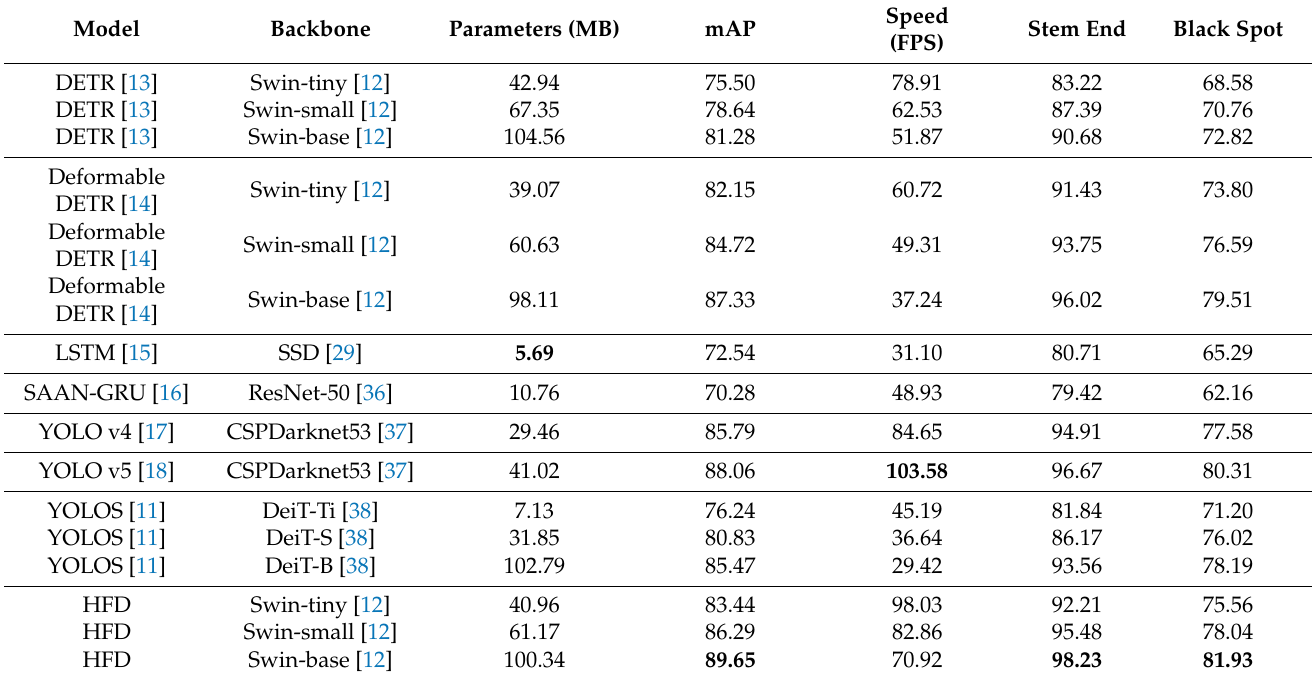
Table 2. Comparison of HFD with other network architecture.